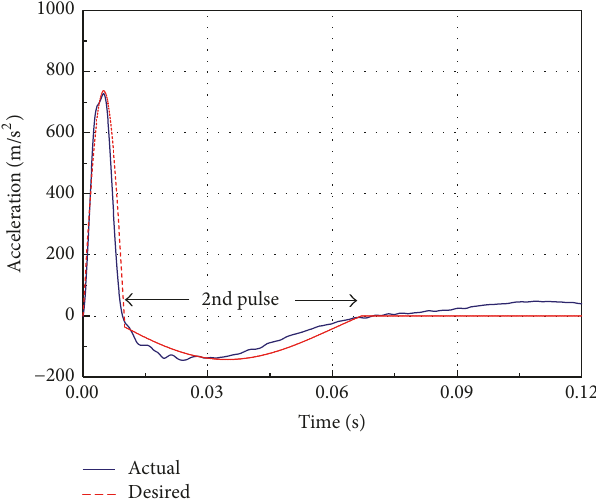
Figure 13: Comparison test and simulation results (Test #4: 3 A).